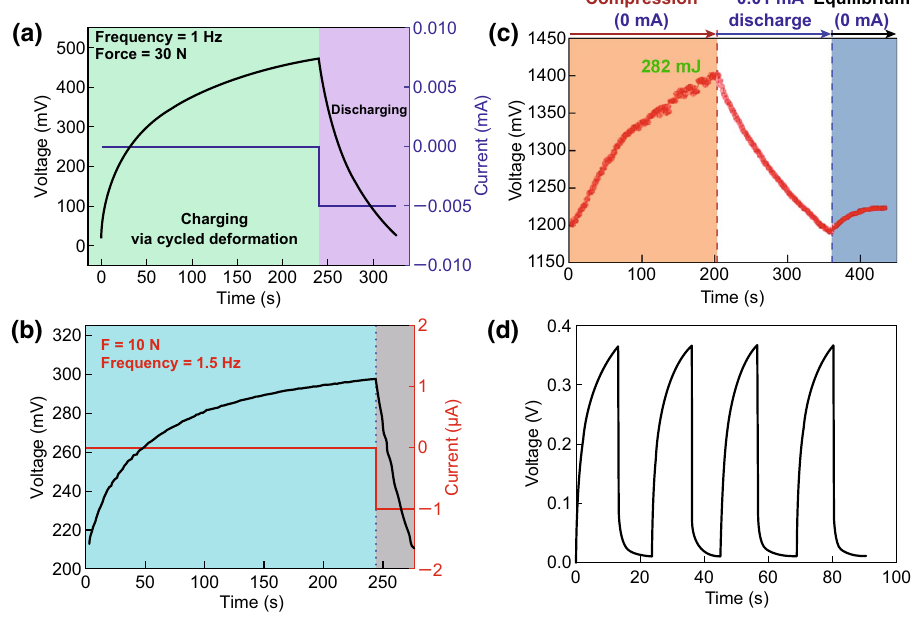
Fig. 9 a Self‑charging process of an all‑solid‑state SCPC under periodic applied force. Reprinted with permission from Ref. [11]. b Self‑charg‑ ing process applying cycled mechanical compressive strain to the device based on PVDF–PZT nanocomposite film as piezo‑separator. Reprinted with permission from Ref. [12]. c A typical self‑charging profile comprising three regions: a compression region inducing self‑charging over an initial 200 s when continuous mechanical compression of 282 mJ was applied at 1 Hz to the cell. Reprinted with permission from Ref. [13]. d The device was charged at a constant current of 5 mA and discharged at a constant load of 5 kΩ in an N 2 saturated buffer. Reprinted with per‑ mission from Ref.